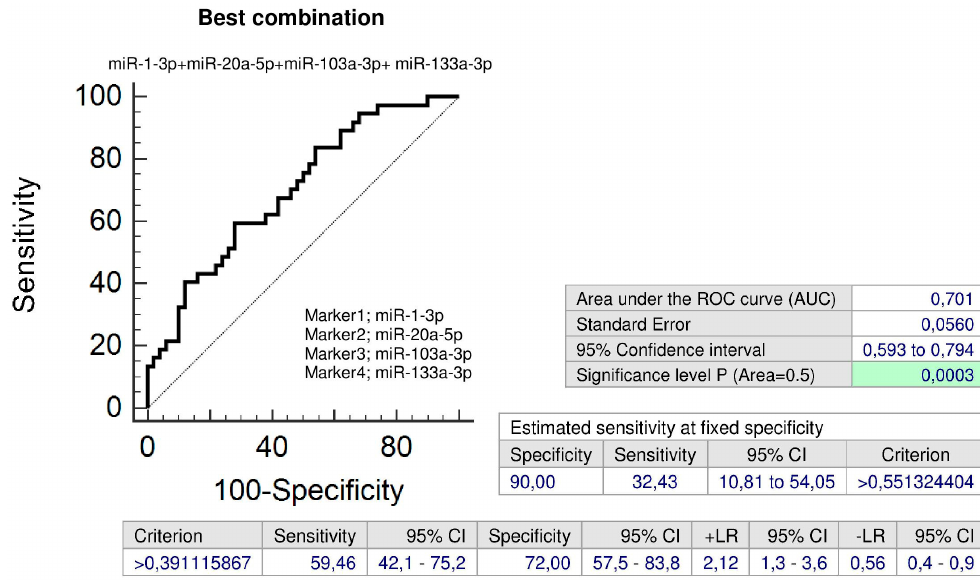
Figure 13. Combined postnatal screening of microRNAs in the identification of children with abnormal postnatal clinical findings descending from late PE pregnancies. Postnatal screening based on the combination of miR-1-3p, miR-20a-5p, miR-103a-3p, and miR-133a-3p showed the highest accuracy for the identification of children with abnormal clinical findings with a prior exposure to late PE at a higher risk of later development of cardiovascular/cerebrovascular diseases.